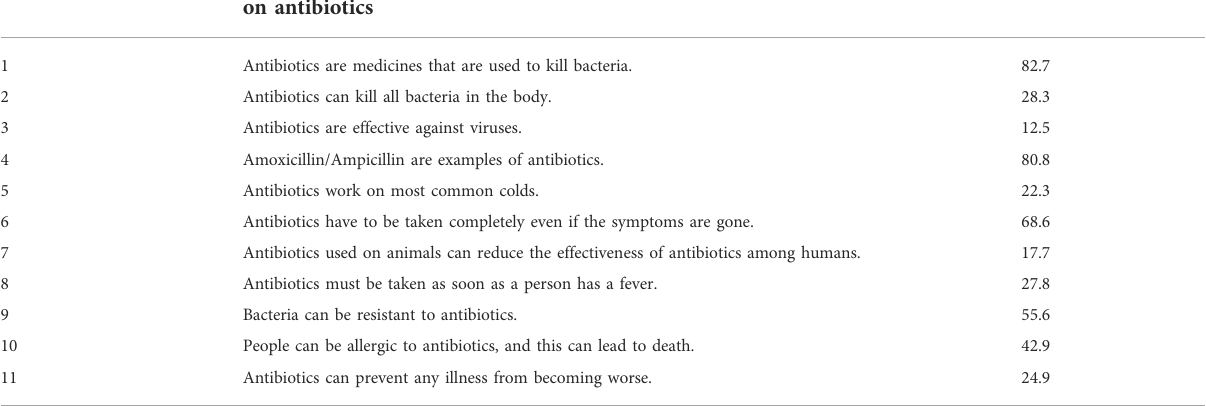
TABLE 2 Percentages of respondents with correct knowledge. Item